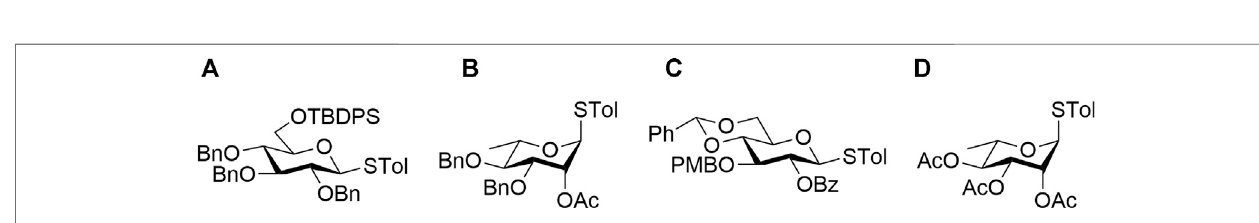
FIGURE 2 | Two target trisaccharide fragments common to glycoform I and glycoform II, respectively.